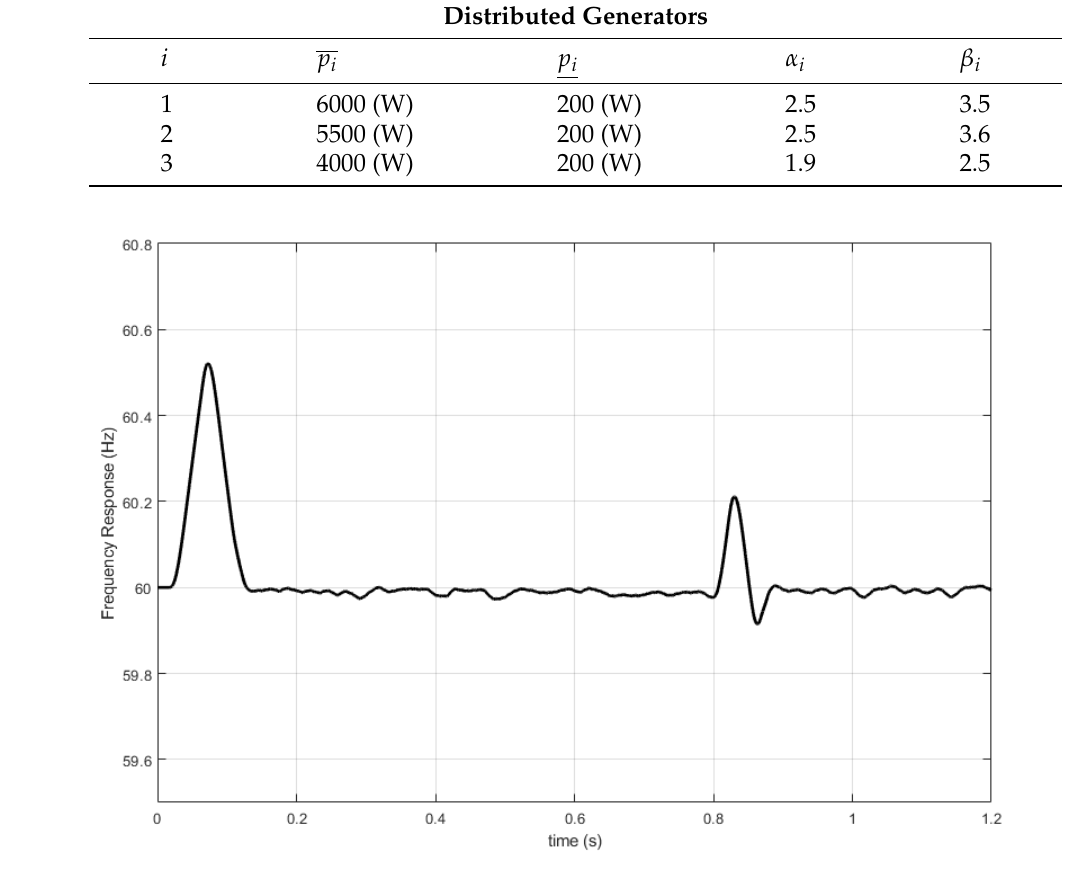
Figure 3. Frequency response of the distribution